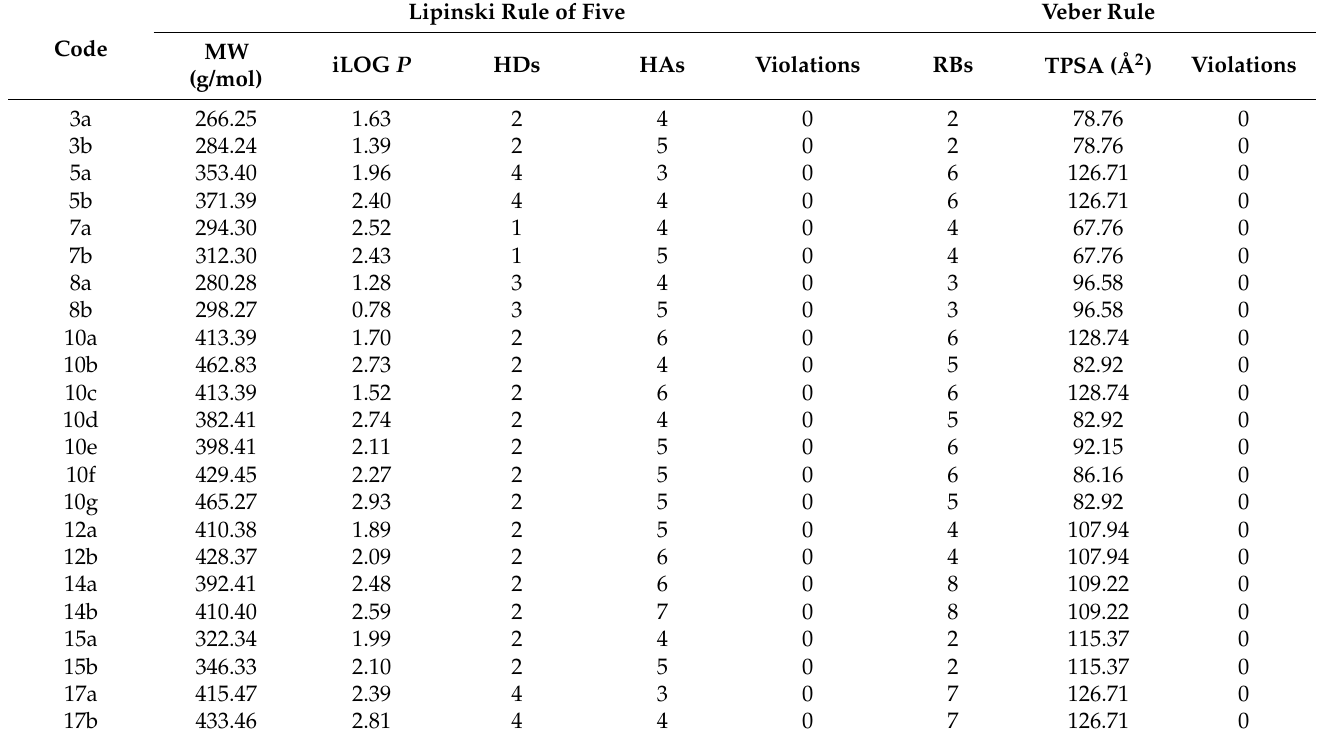
Table 7. Lipinski and Veber Parameters of the synthesized compounds 3a , b – 17a , b